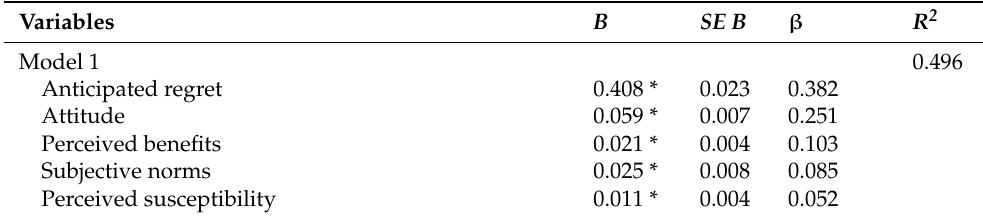
Table 2. Results from regression analysis combining the constructs and significant demographic characteristics (education, income, history of COVID-19, and